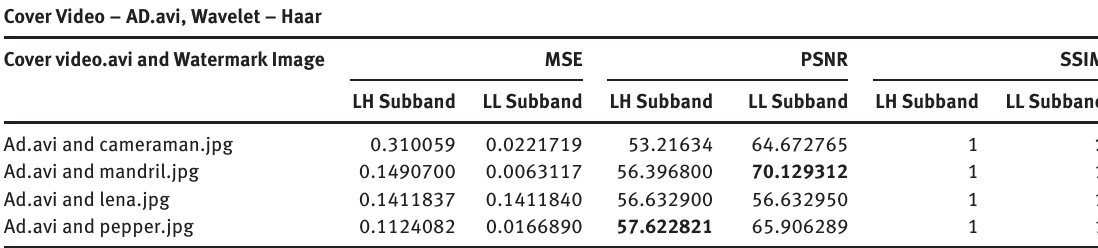
Table 2: Performance Evaluation of Encoder for Imperceptibility Using the LH Subband (Algorithm 1). Cover Video – AD.avi, Wavelet – Haar Cover video.avi and Watermark Image